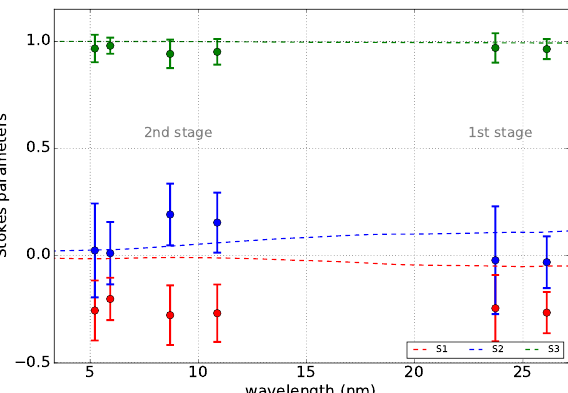
Figure 8. Impact of the LDM transport optics on the Stokes parameters ( red = S 1 / S 0 , blue = S 2 / S 0 and green = S 3 / S 0 ) for a circularly polarized light. (dashed lines: predicted Stokes parameters; points: experimental